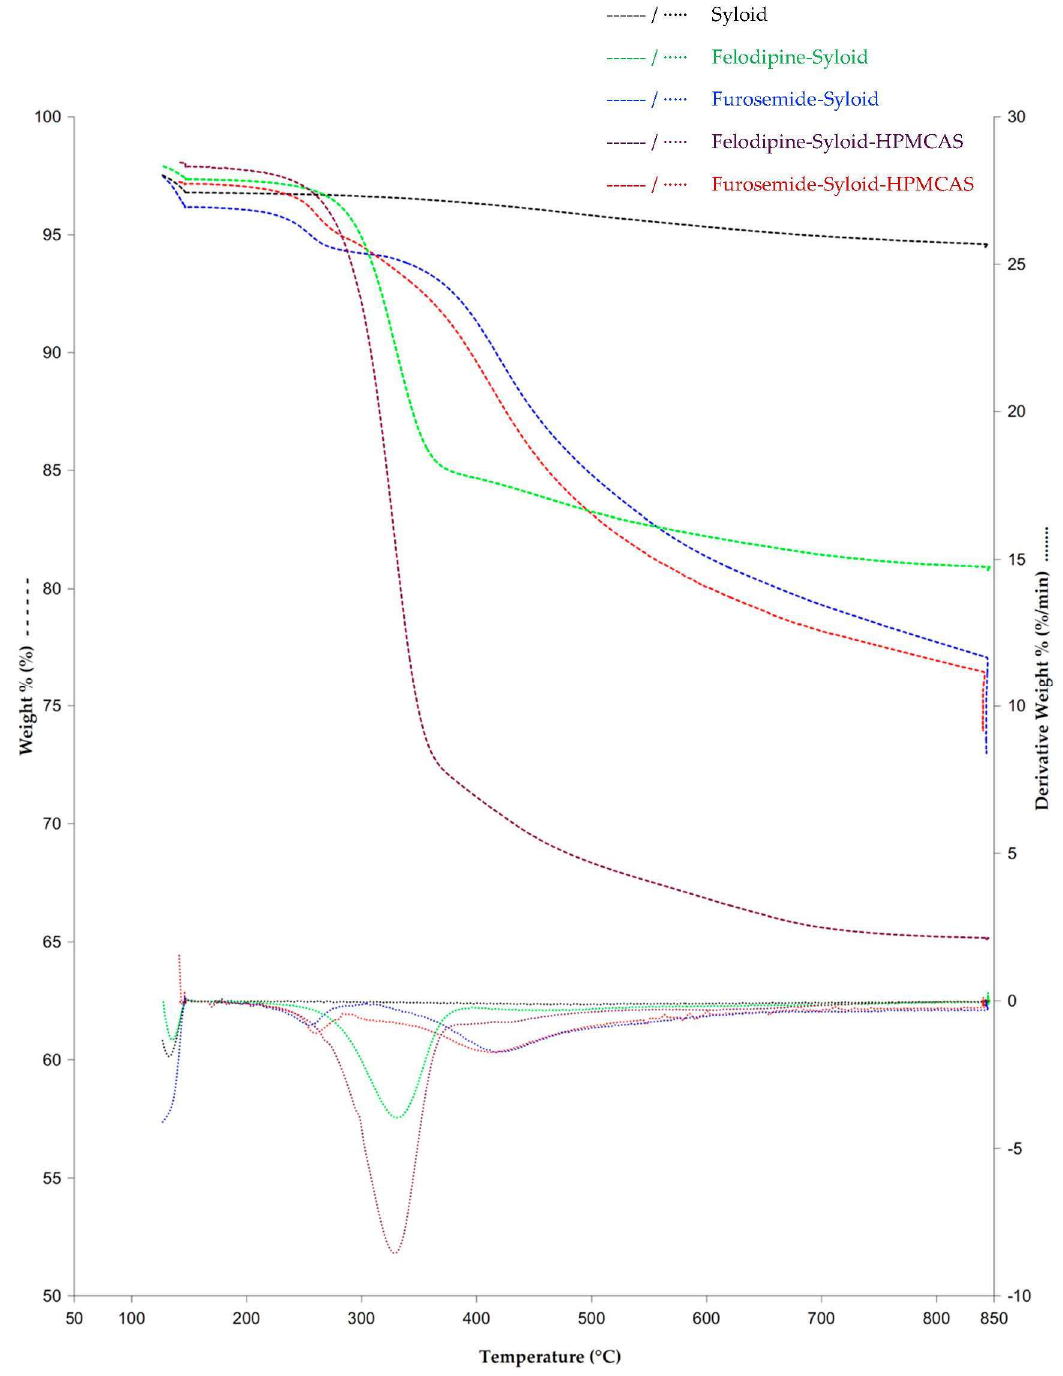
Figure 5. TGA weight% versus temperature and derivative weight% curves of Syloid, Felodipine-Syloid, Furosemide-Syloid, Felodipine-Syloid-HPMCAS, and Furosemide-Syloid-HPMCAS at a drug load of 300% surface coverage. Temperature programme under a nitrogen flow of 20 mL/min: (1) heat from 50 °C to 120 °C and held for 5 min at 120 °C; (2) heat from 120 °C to 800 °C at a heating rate of 20 °C/min; (3) held for 30 min at 800 °C.